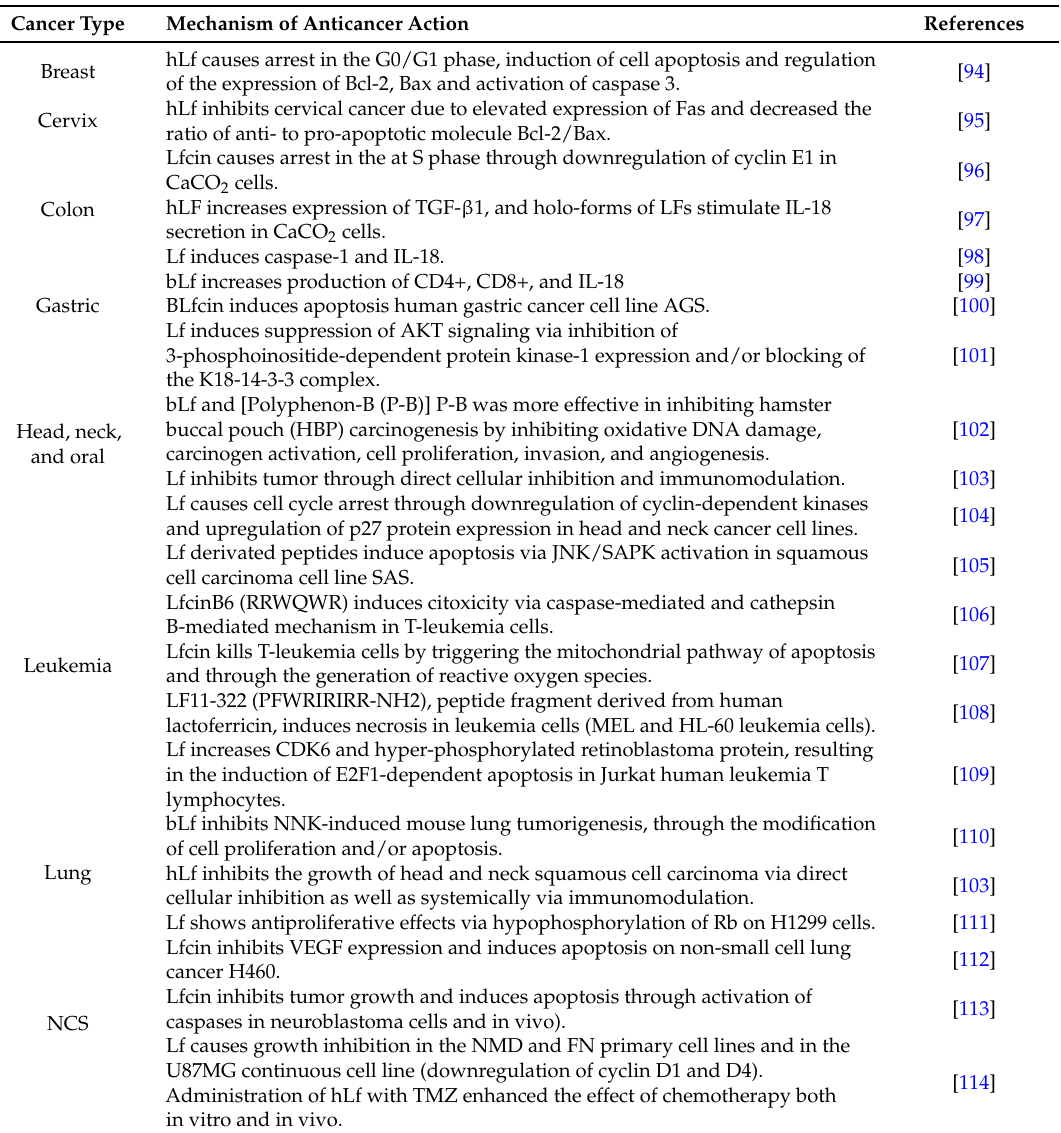
Table 1. Anticancer activities of lactoferrin and